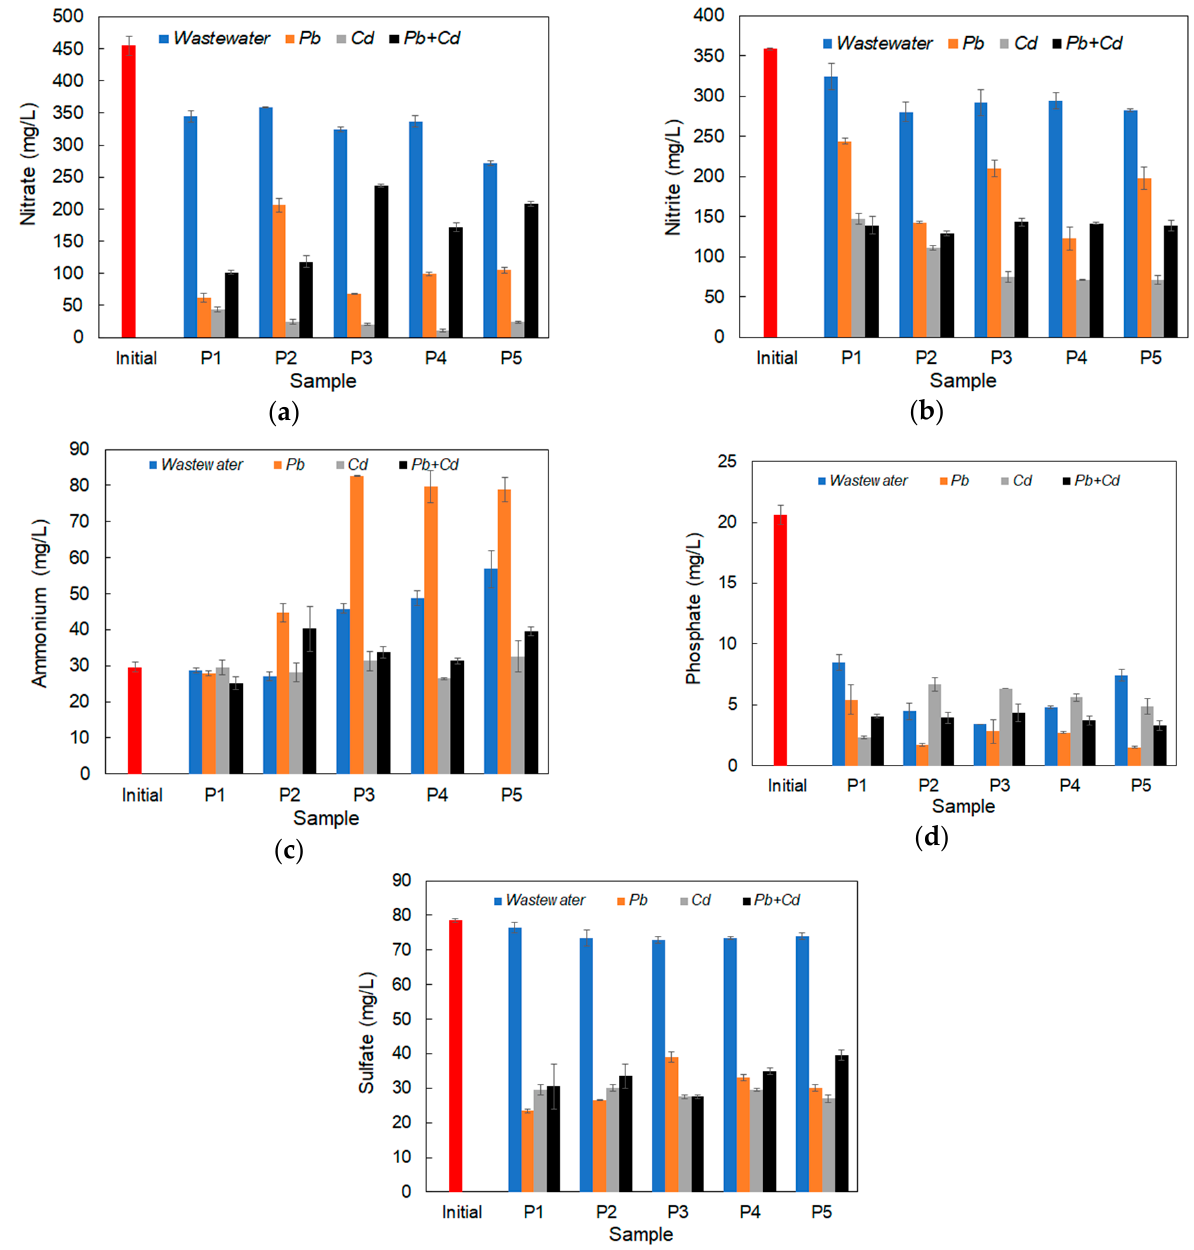
Figure 5. Removal efficiency of nutrients from synthetic wastewater after 120 h: ( a ) nitrate ions; ( b ) nitrite ions; ( c ) ammonium ions; ( d ) phosphate ions; ( e ) sulfate ions.